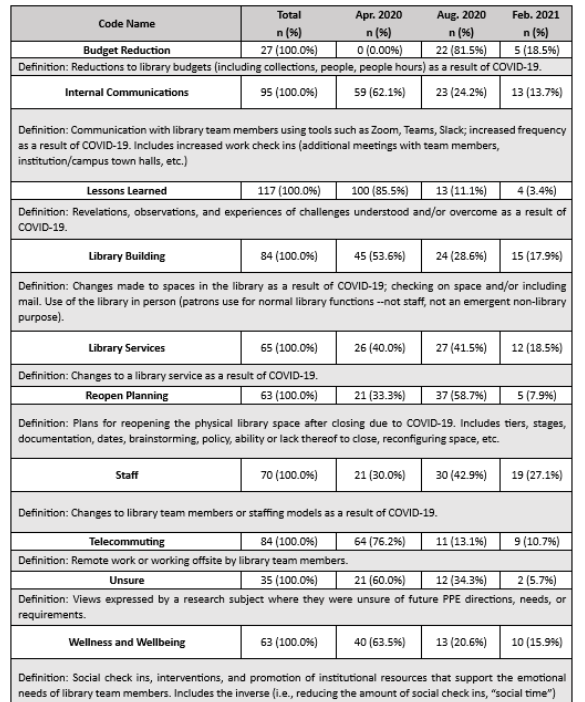
Table 4 Ten areas analyzed using staff as a lens for understanding the connection between